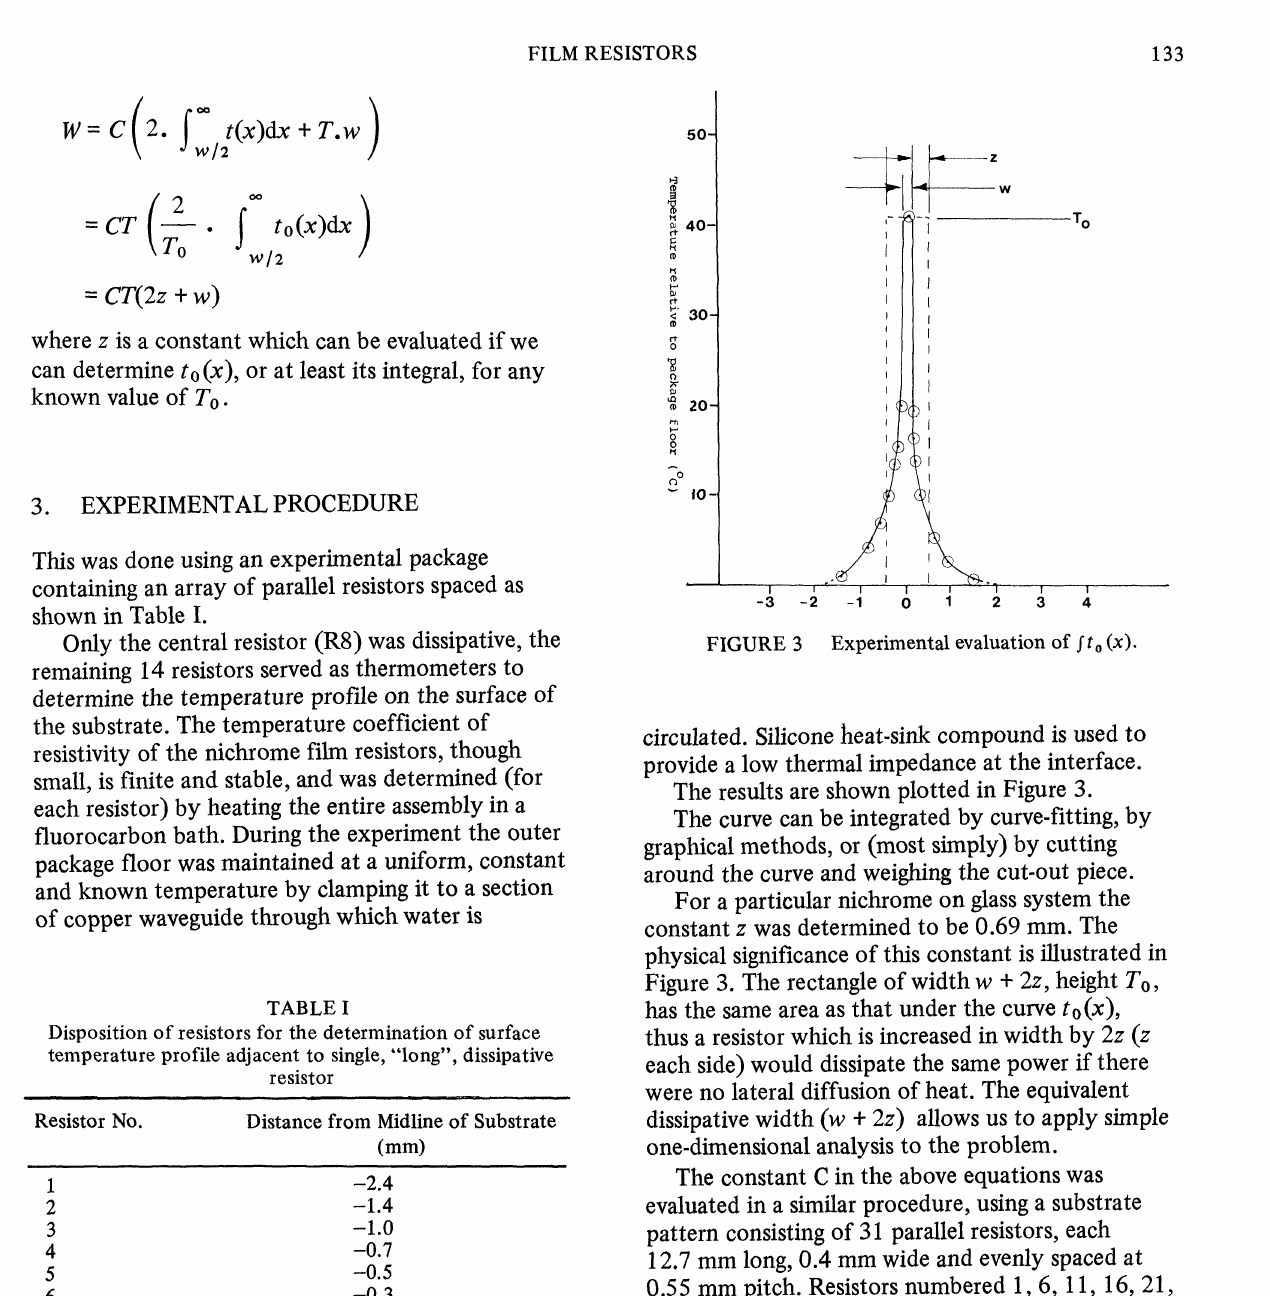
All resistors were 0.1 mm wide, 16.5 mm long.